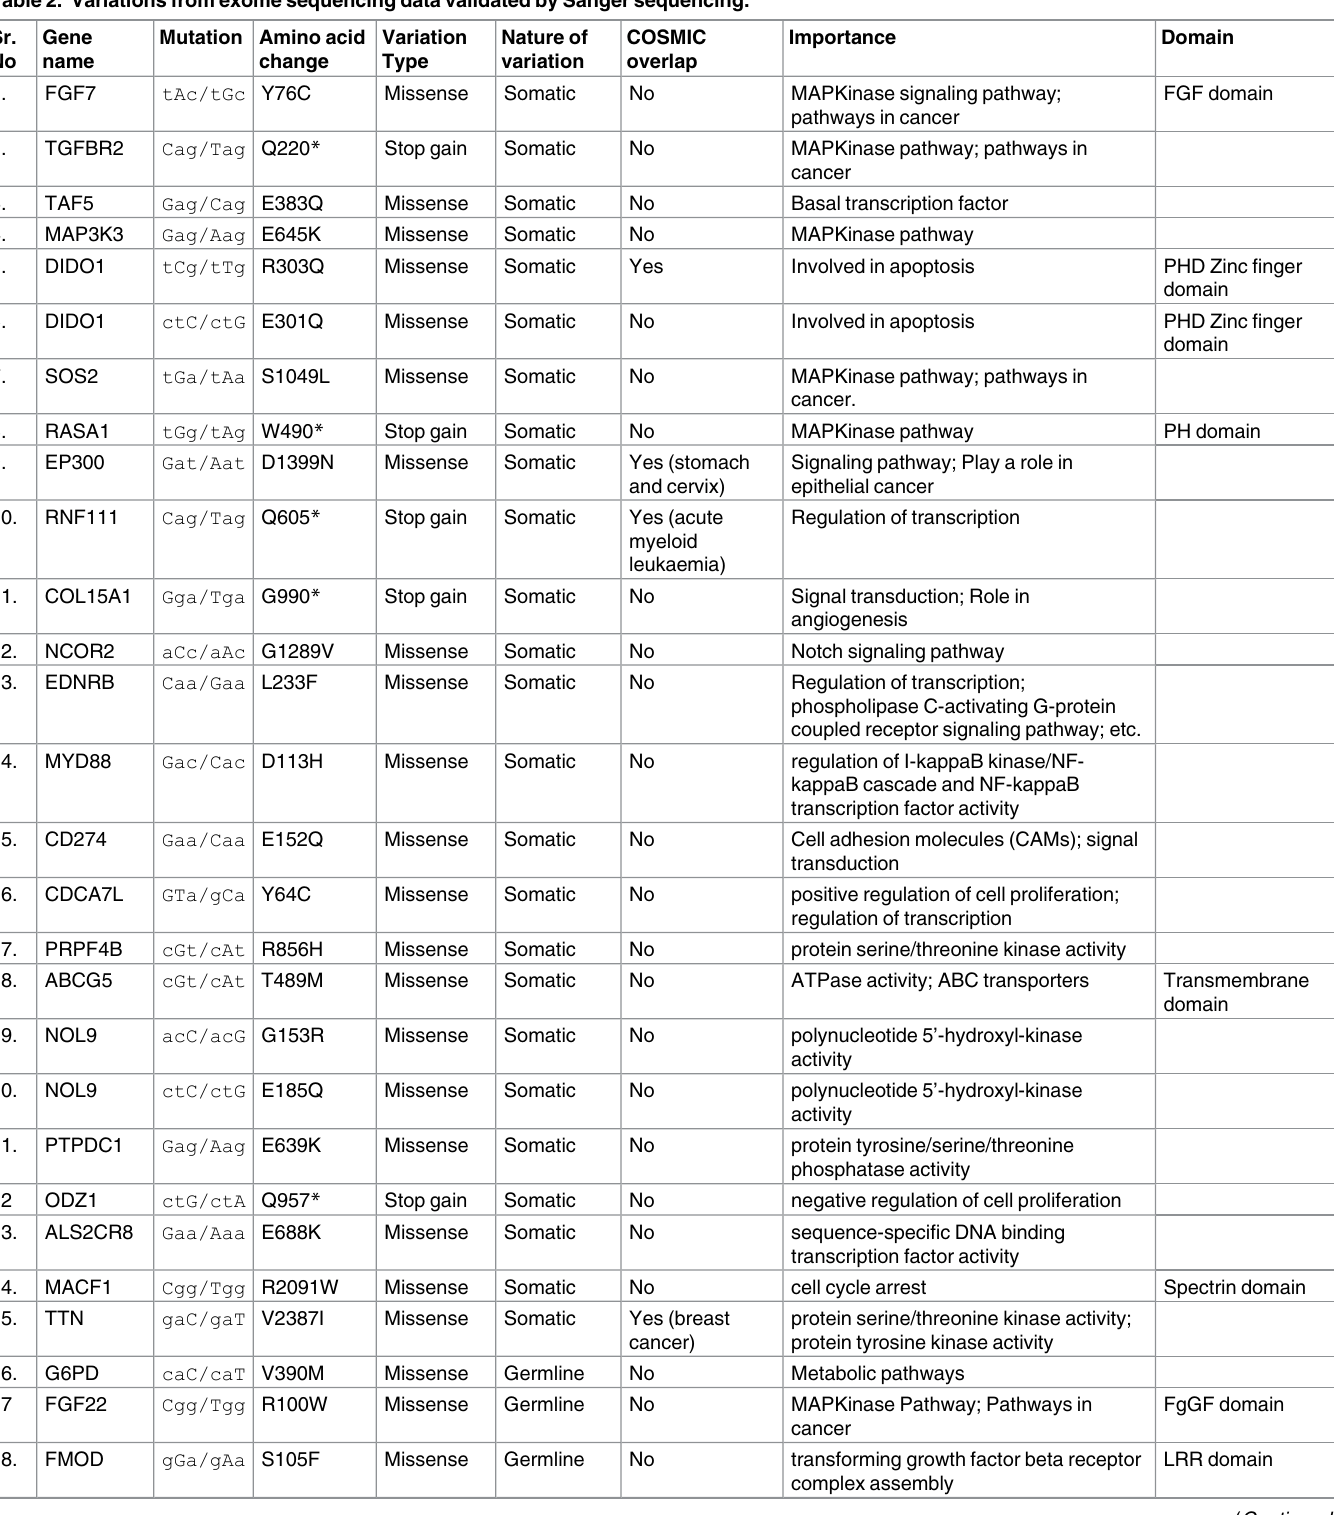
Table 2. Variations from exome sequencing data validated by Sanger sequencing. Sr.